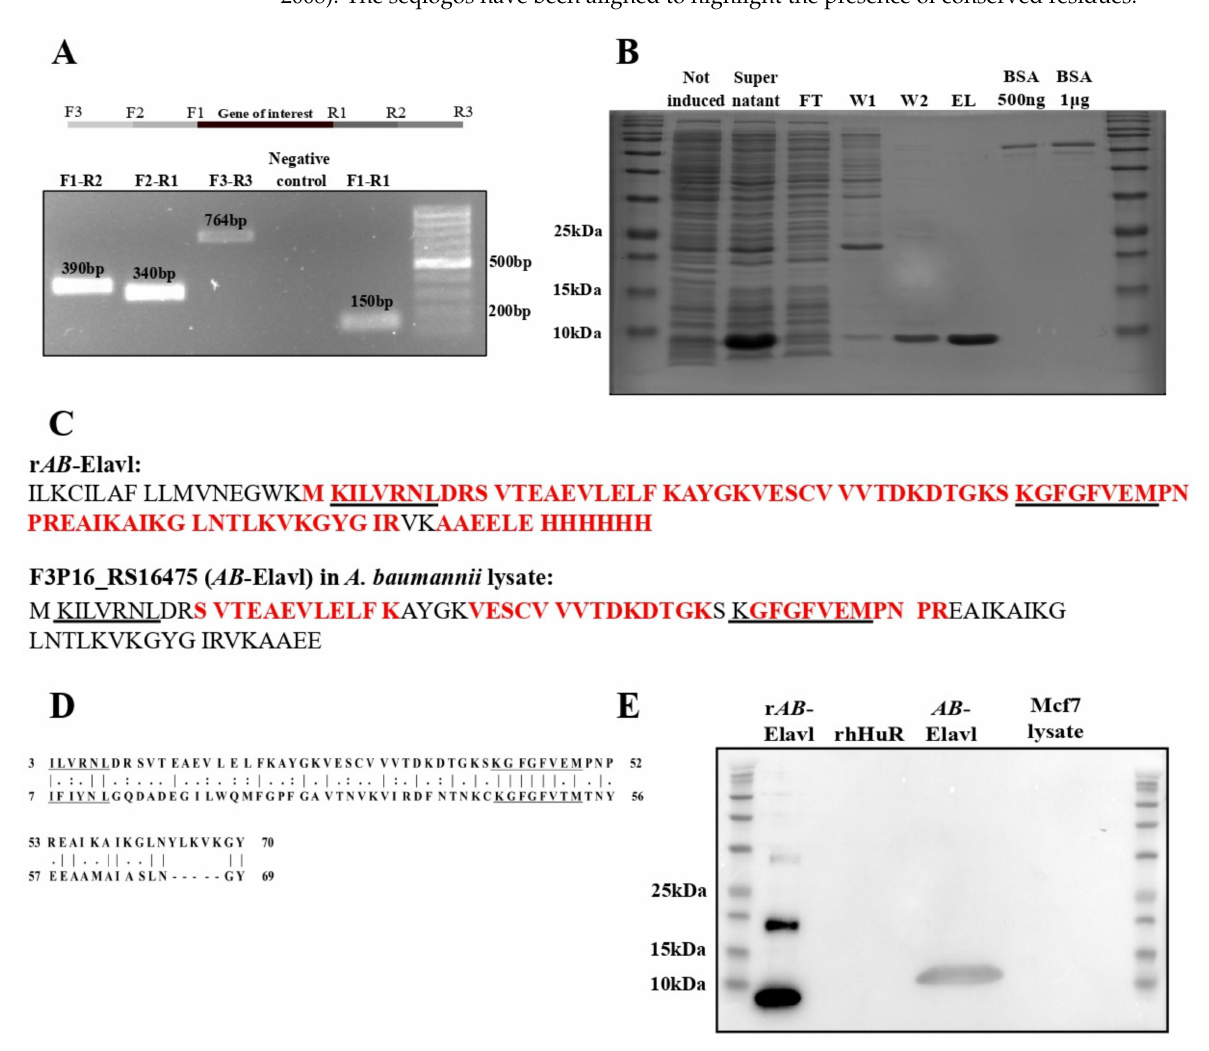
Figure 2. Protein identification and purification. ( A ) PCR amplification of the transcription of the polycistronic mRNA containing the sequence of interest. The amplicons produced are 390 bp for F1-R2, 340 bp for F2-R1, 764 bp for F3-R3 and 150 bp for F1-R1 (this amplicon was also used as positive control). Neg_ctrl: negative control. ( B ) Purification of the recombinant protein. FT: flow through, W: wash, EL: elution. ( C ) Mass spectrometry analysis. The recombinant protein was analyzed at